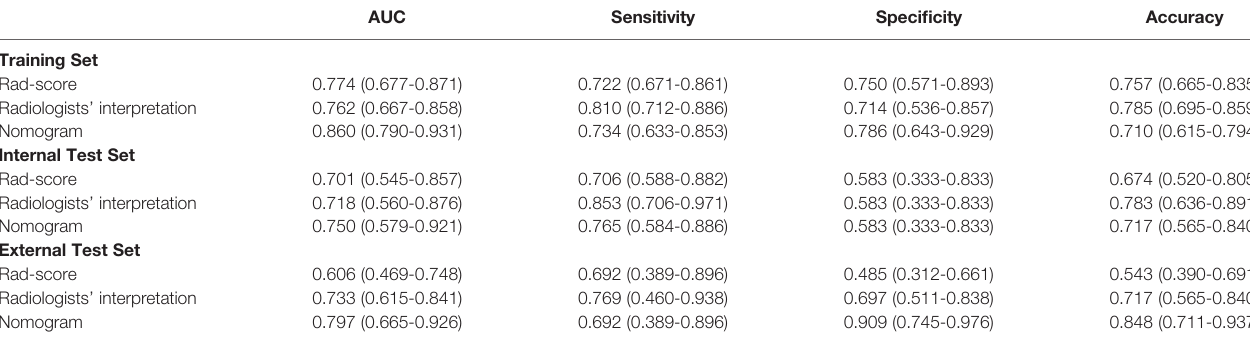
TABLE 4 | Ef fi cacies of the models predicting ETE in patients with